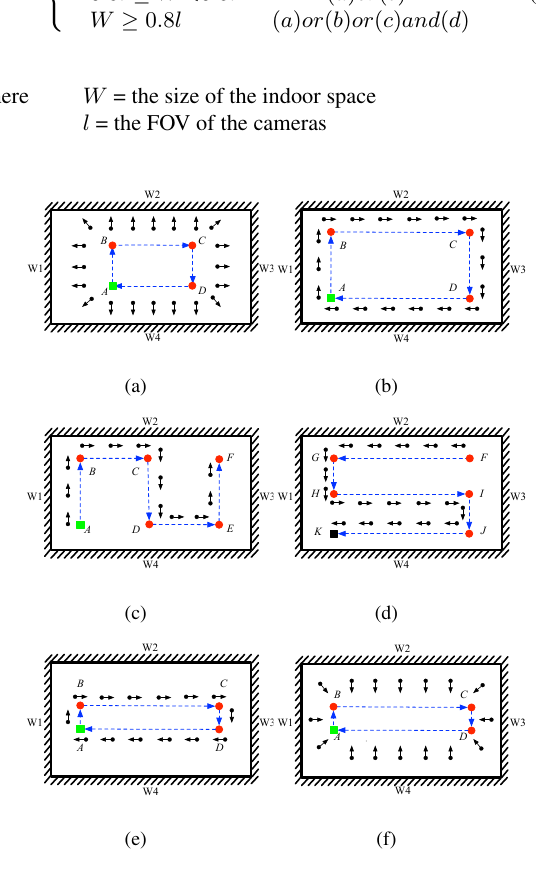
Figure 6. Flight paths for the QUAV. Figure 6 illustrates the flight paths for the QUAV. In these flight paths, green and black squares are the starting points and end- ing points respectively. Red dots are the turning points and the arrow with the black dotted tail denotes the direction of the cam- era. The thick lines with black slashes comprise the wall and blue dotted arrows are flight paths. For environments where Figure 5. Camera positioning, free space and the FOV of the camera.